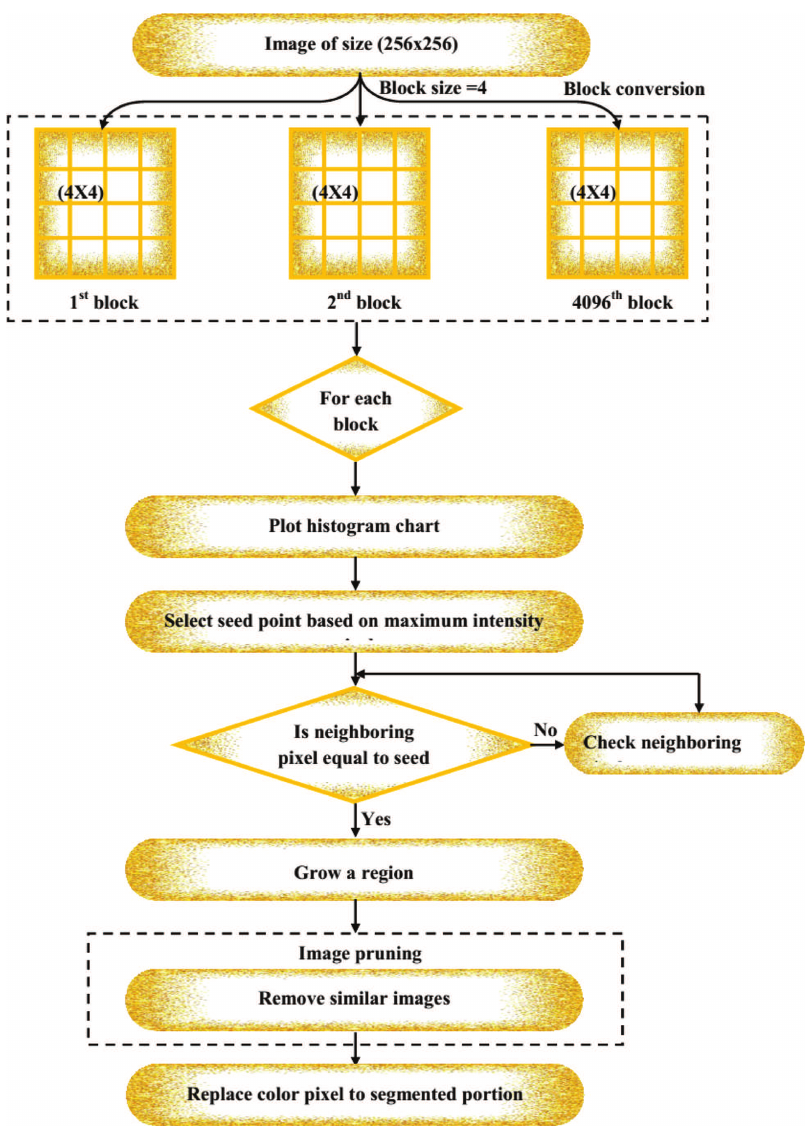
Figure 2: Flowchart of the MRG